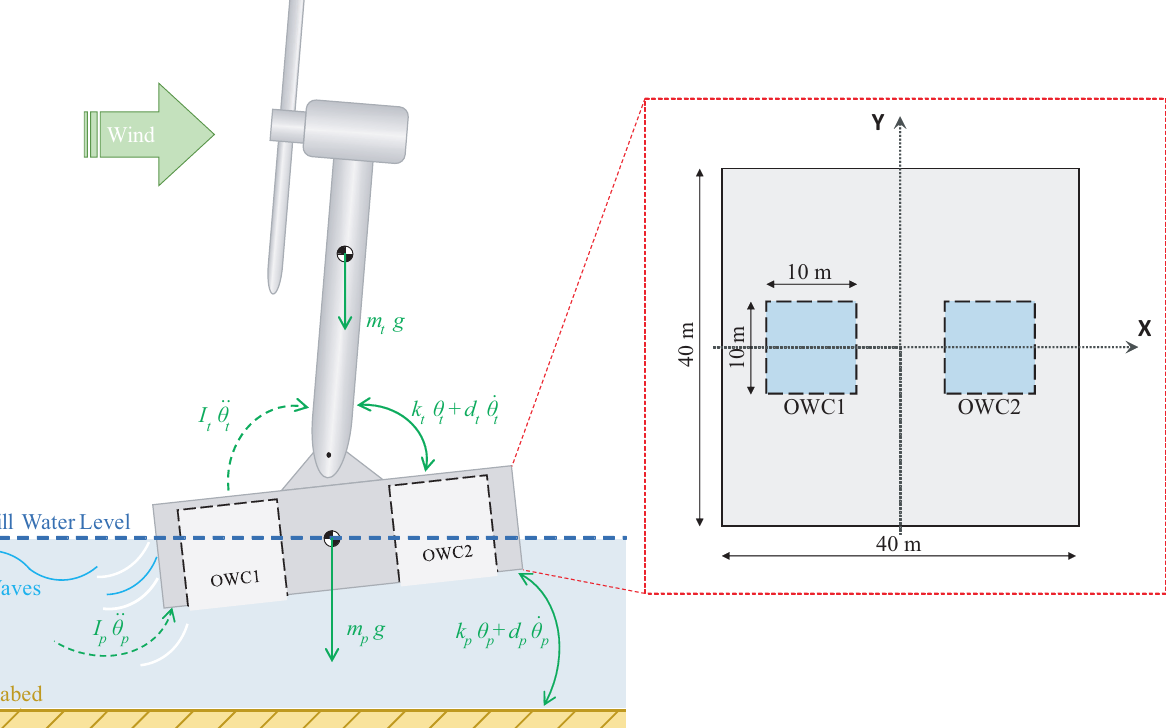
Figure 2. Simplified model of floating offshore wind turbine.